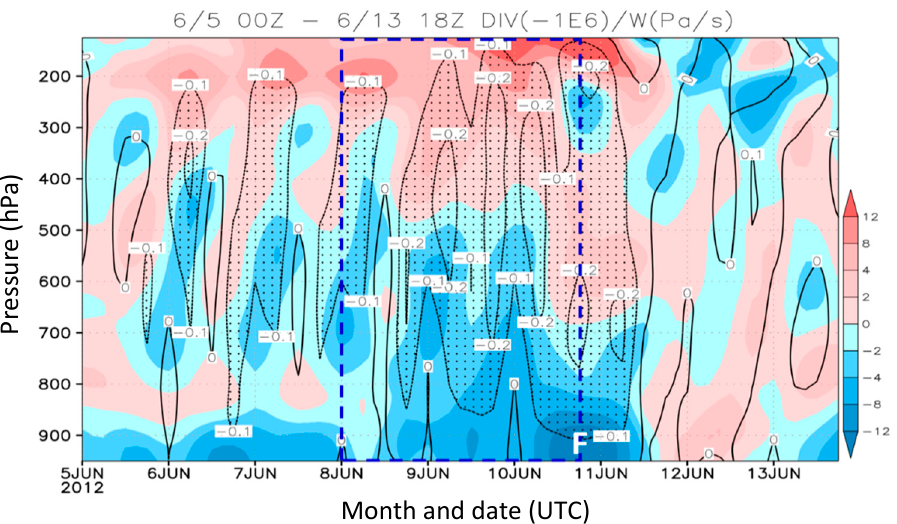
Figure 14. As in Figure 12b, but showing the divergence ( D , color, 10 − 6 s − 1 ) in South China, in addition to the rising motion in ω (Pa s − 1 , stippled for ω < − 0.1 Pa s − 1 ).